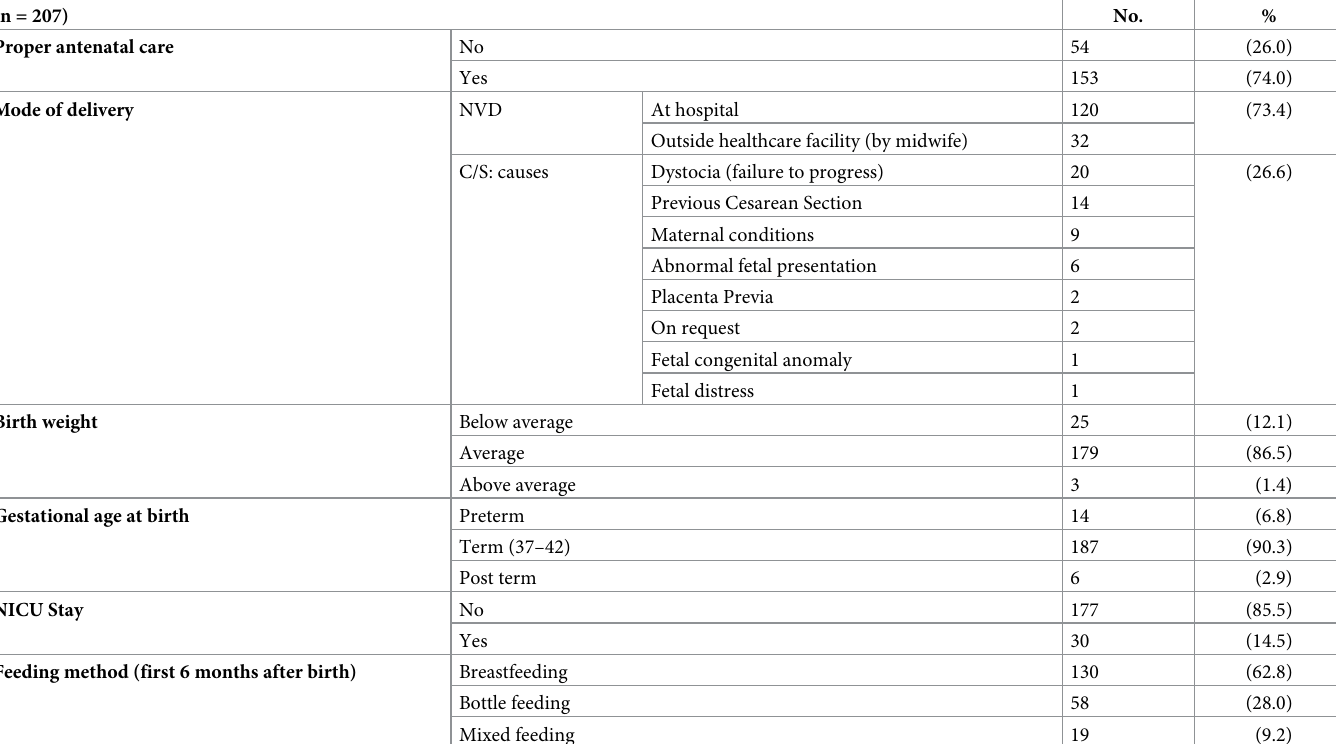
Table 3. Pregnancy and birth